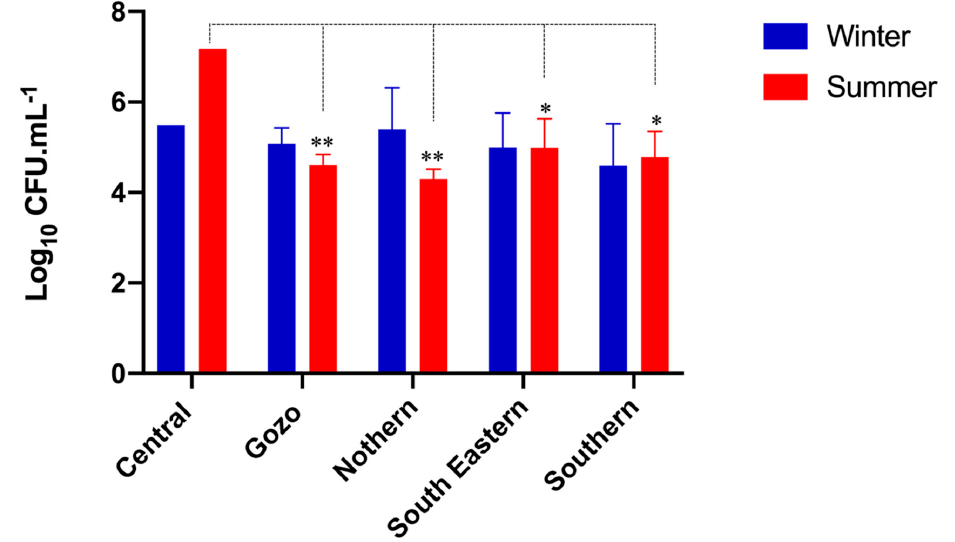
Figure 1. Average total viable counts (TSA counts) presented per geographical region for winter and summer seasons (* p < 0.05, ** p < 0.01).